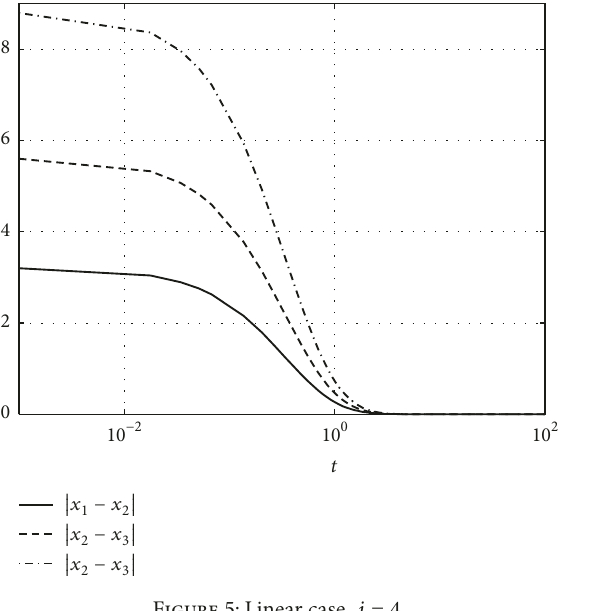
Figure 7: Linear case, 𝑗 = 6